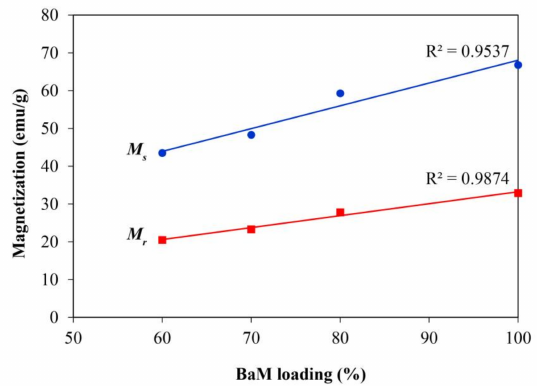
Figure 7. Remanent magnetization ( M r ) and saturation magnetization ( M s ) as a function of ferrite loading in BaM-ABS composites. The loading of 100% corresponds to the BaM